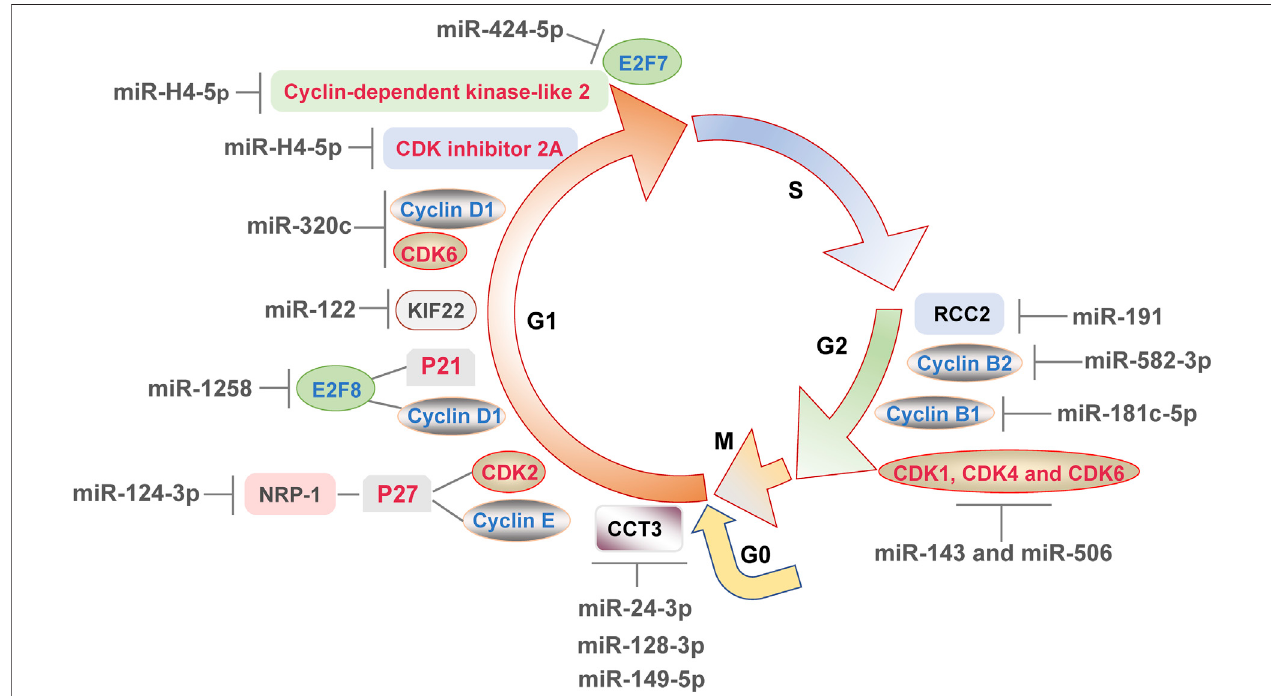
FIGURE 2 | MicroRNAs directly or indirectly affect the expression of various components involved in the cell cycle, leading to cell cycle progression or arrest and fi nally regulating the DNA damage response.